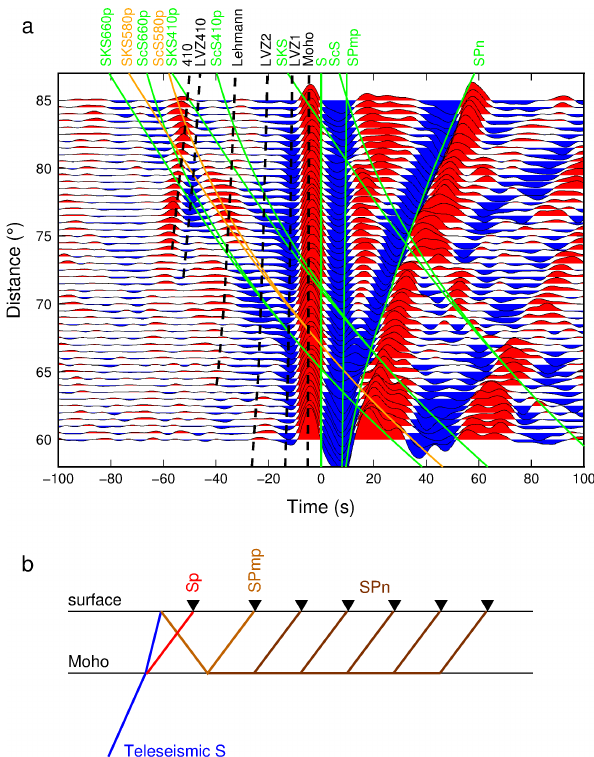
Figure 3. (a) Display of binned S-receiver functions as a function of the epicentral distance. Each bin contains more than one thou- sand traces. Precursors of the S phase from S-to-P conversions in the upper mantle are marked with dashed black lines (410 conver- sion at the 410, LVZ410 conversion at a velocity reduction directly above the 410, Lehmann–Lehmann discontinuity, LVZ1, LVZ2 con- versions at velocity reductions between Moho and Lehmann, Moho conversion at the Moho). LVZ2 and Lehmann are more clear in Fig. 4; they are marked here for comparison. Additional theoretical travel-time curves of ScS, SKS, S-to-P conversions of ScS and SKS at the 410 and 660 discontinuities and at a possible discontinuity at 580km depth (ScS410p, ScS580p, ScS660p, SKS410p, SKS580p, SKS660p), crustal multiples (SPmp) and SPn are marked in green. (b) Ray paths of Sp, SPmp and SPn.